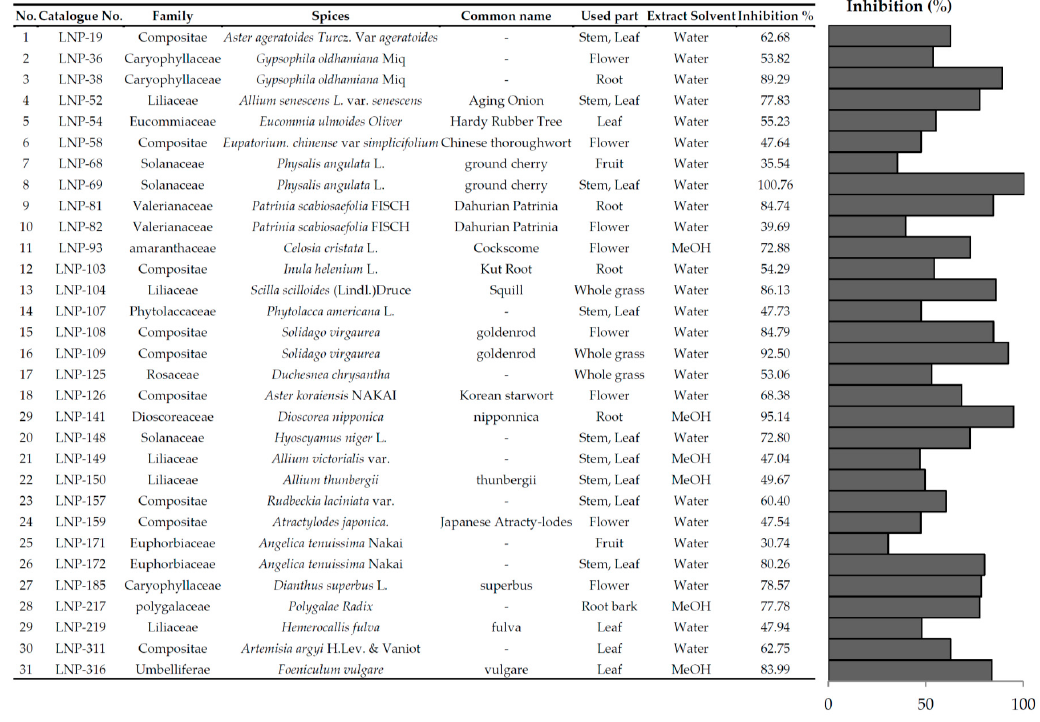
Table 1. List of natural extracts that demonstrate 30% or more inhibition of adipogenesis in 3T3-L1 cells. 3T3-L1 cells differentiated with differentiation media in the absence or presence of natural extracts for 8 days (concentration: 10 µ